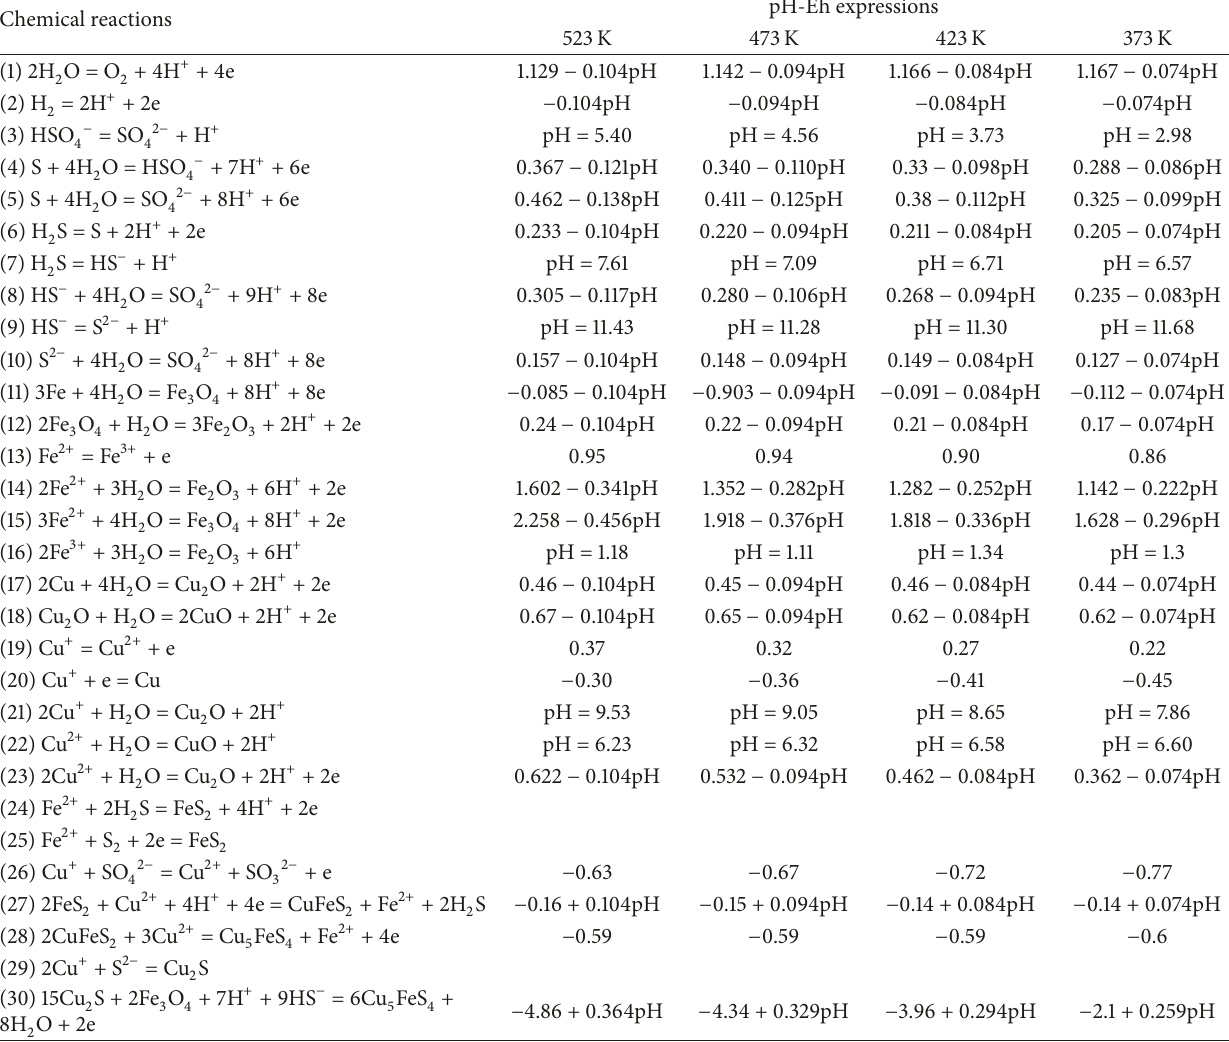
Table 2: Chemical reactions and Eh-pH expressions.